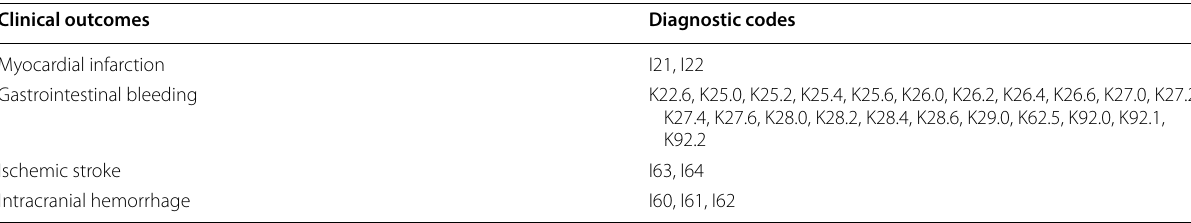
Table 1 Diagnostic codes (ICD-10) for clinical outcomes Clinical